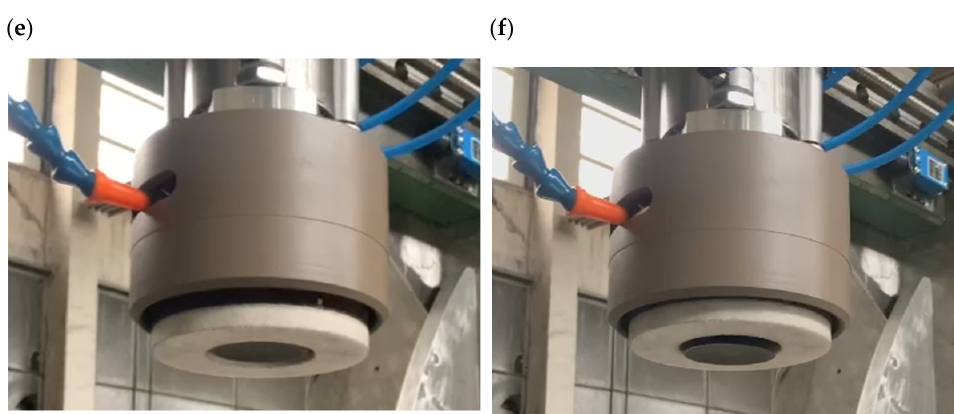
Figure 6. View of the dual-tool grinding head: ( a ) in coarse grinding setting—top view; ( b ) in coarse grinding setting—bottom view; ( c ) in finishing grinding setting—top view; ( d ) in finishing grinding setting—bottom view; ( e ) fully equipped head in coarse grinding setting: ( f ) fully equipped head in the finishing grinding setting.